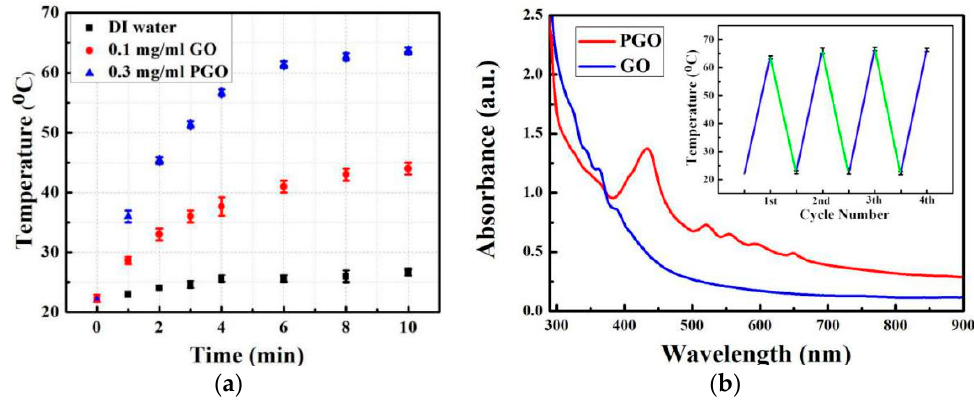
Figure 3. ( a ) Photothermal e ff ects of deionized (DI) water, 0.1 mg / mL GO, and 0.1 mg / mL PGO solution with NIR laser irradiation (808 nm, 2.5 W cm 2 ) for 10 min, and ( b ) UV-vis absorption spectra of GO and PGO solution at the same diluted concentration; the insert is a temperature change of 0.1 mg / mL PGO solution over four laser ON / OFF cycles (laser irradiation 10 min in every